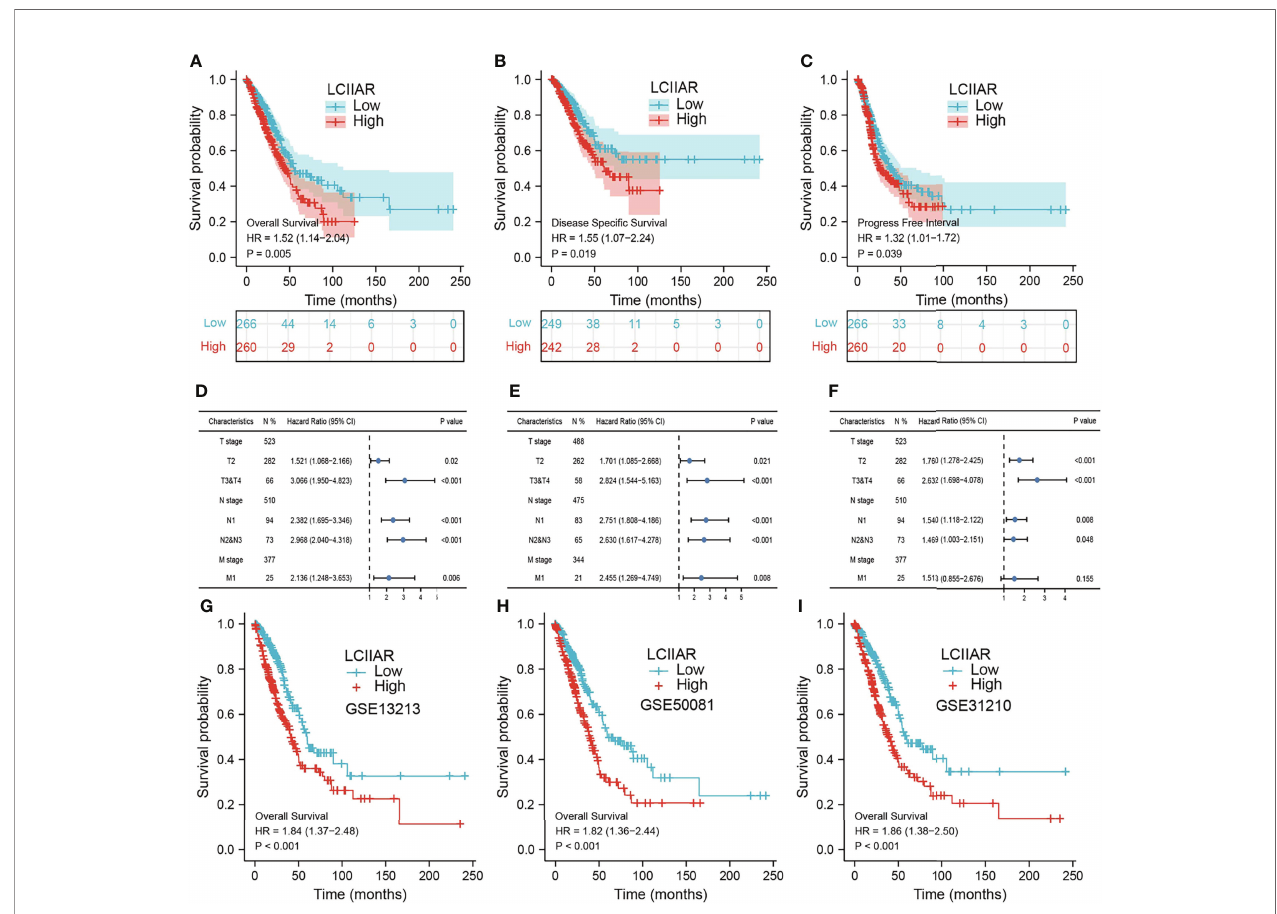
FIGURE 4 | Analysis the prognosis of LCIIAR in LUAD (A – C) The prognosis of LCIIAR in LUAD was examined by TCGA-LUAD dataset (D – F) The prognosis of LCIIAR based on TNM stage subtype. (G – I) Validation of the overall survival of LCIIAR in lung cancer by GEO